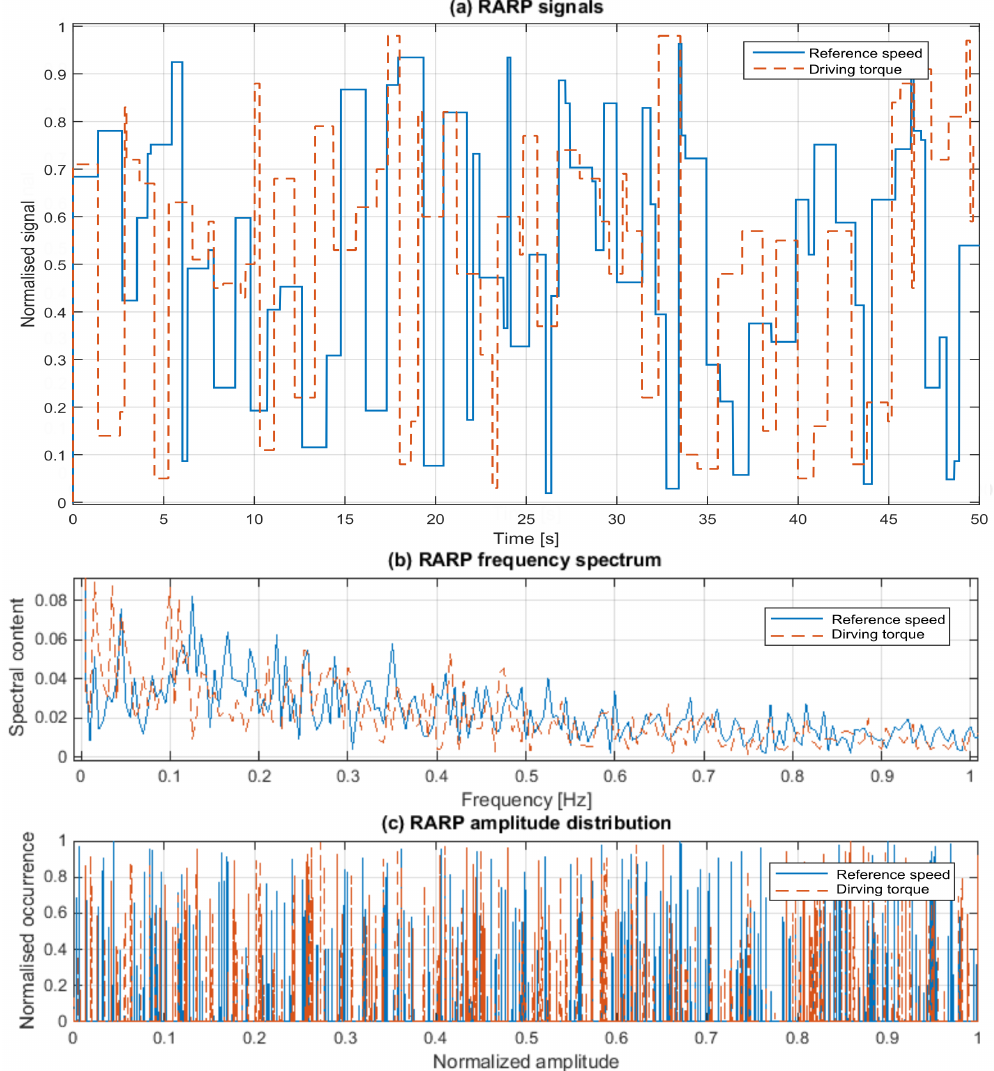
Figure 10. The random-amplitude random-phase (RARP) signals for the reference rotational speed and torque ( a ) and their spectral ( b ) and amplitude ( c )